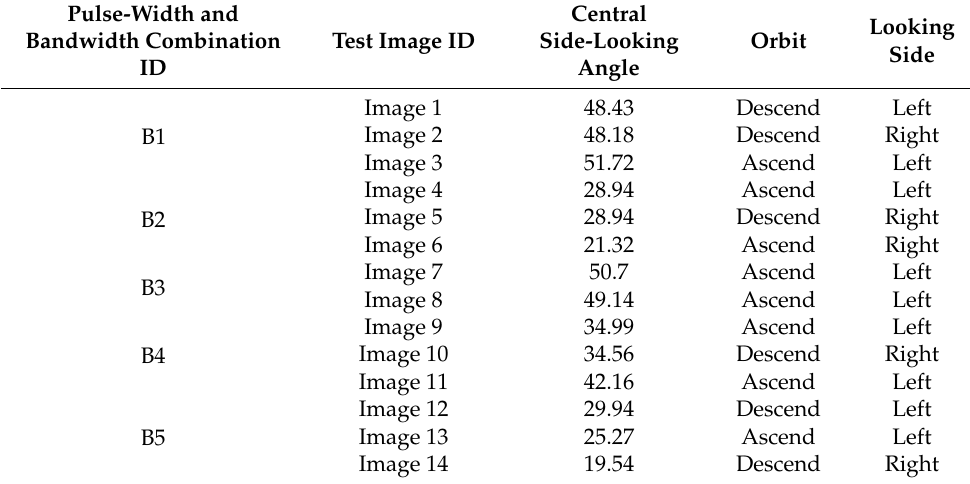
Table 3. Test image